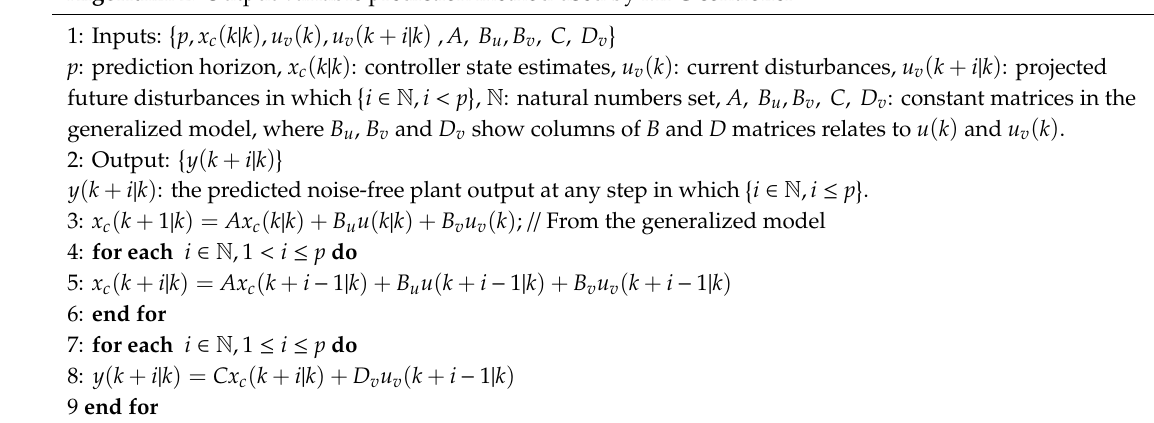
Algorithm 2 . Output variable prediction method used by MPC